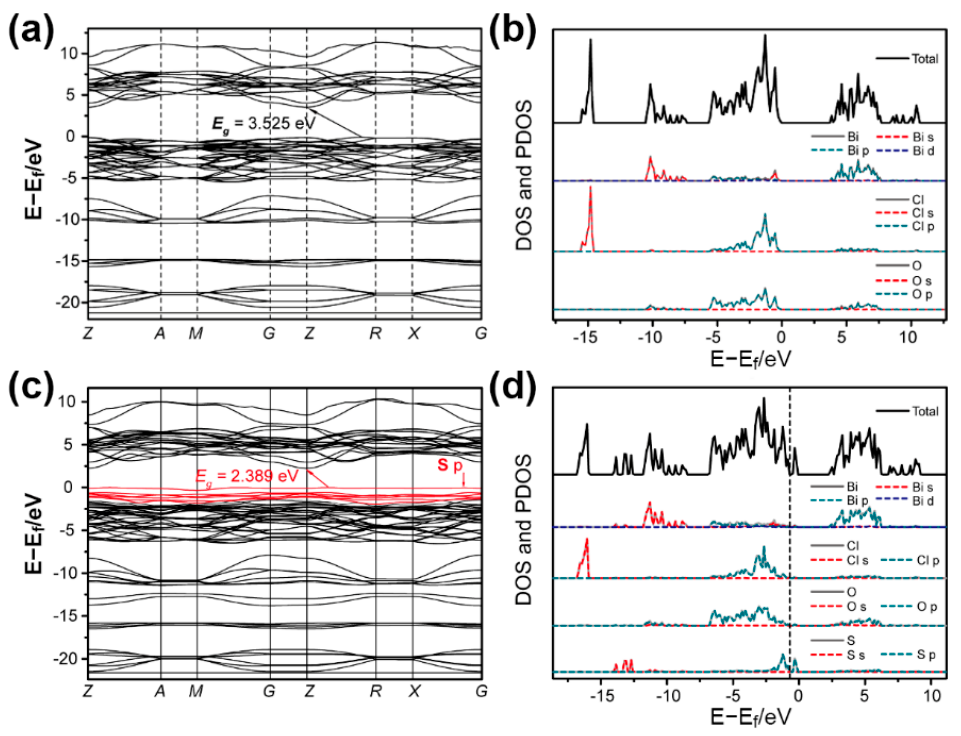
Figure 6. ( a , c ) Calculated band structures, and ( b , d ) calculated total and partial density of states of BiOCl ( a , b ) and BiOCl 2/3 S 1/3 ( c , d ).